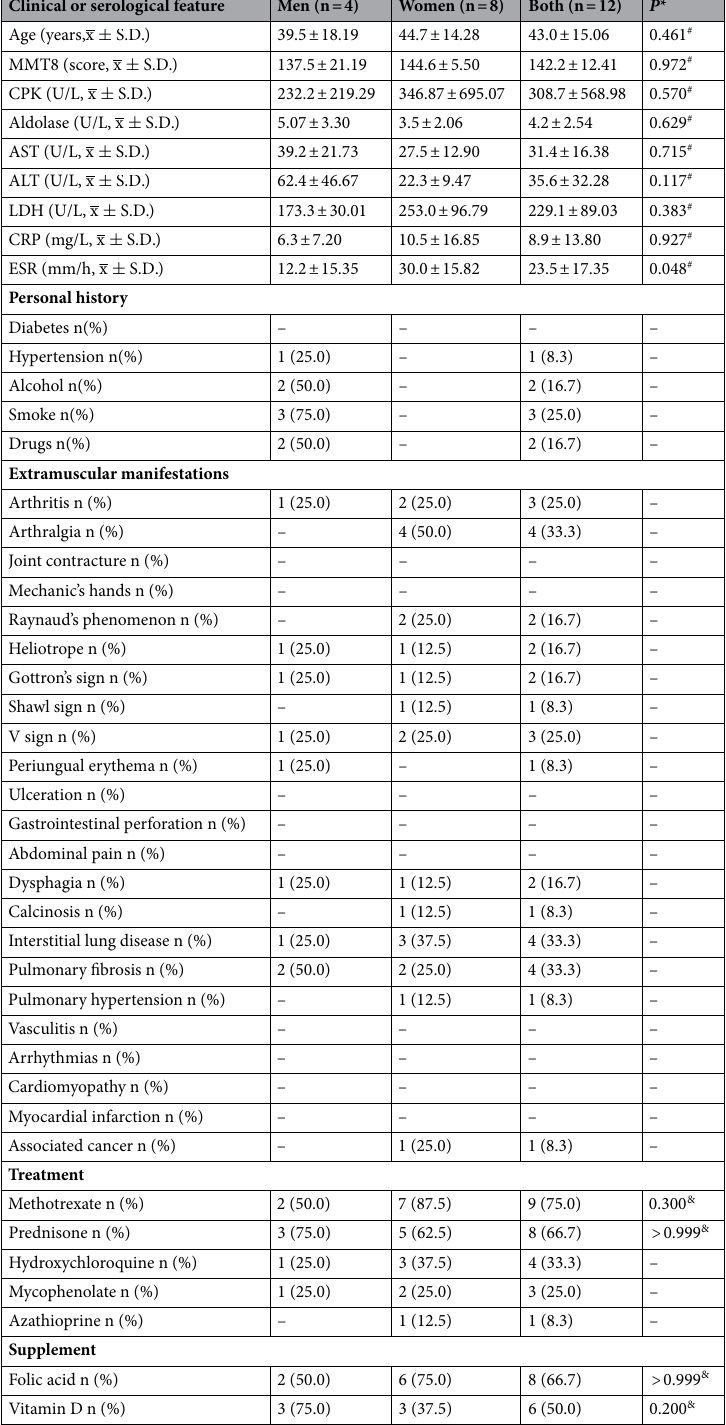
Table 1. Clinical and serological features of patients classified with Idiopathic Inflammatory Myopathies in our study group. IIM idiopathic inflammatory myopathies; x mean; S.D. standard deviation; MMT8 Manual Muscle Testing 8; CPK creatine phosphokinase; AST aspartate aminotransferase; ALT alanine aminotransferase; LDH lactate dehydrogenase; CRP C-reactive protein; ESR erythrocyte sedimentation rate. *Only the characteristics of men and women were included in the statistical analysis. # Mann–Whitney U with Fisher’s Exact test. & Fisher’s exact for contingency tables